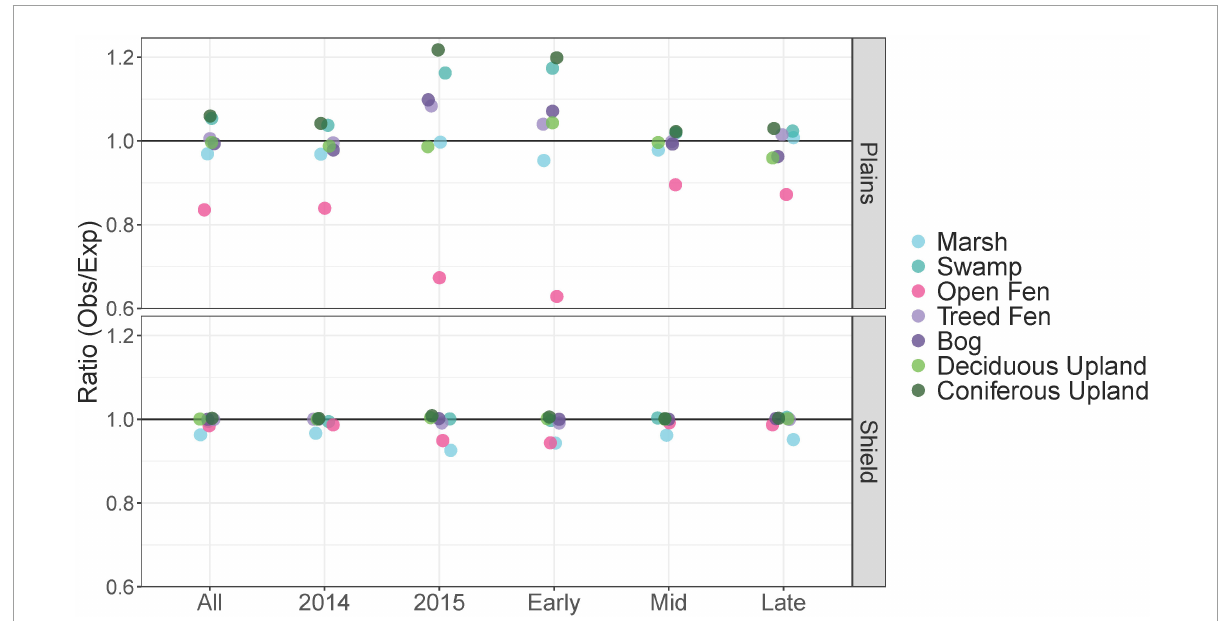
FIGURE7 Observed/Expected ratios of area burned for 2014, 2015, early, mid, and late season for the Taiga plains (top) and Taiga shield (bottom) .